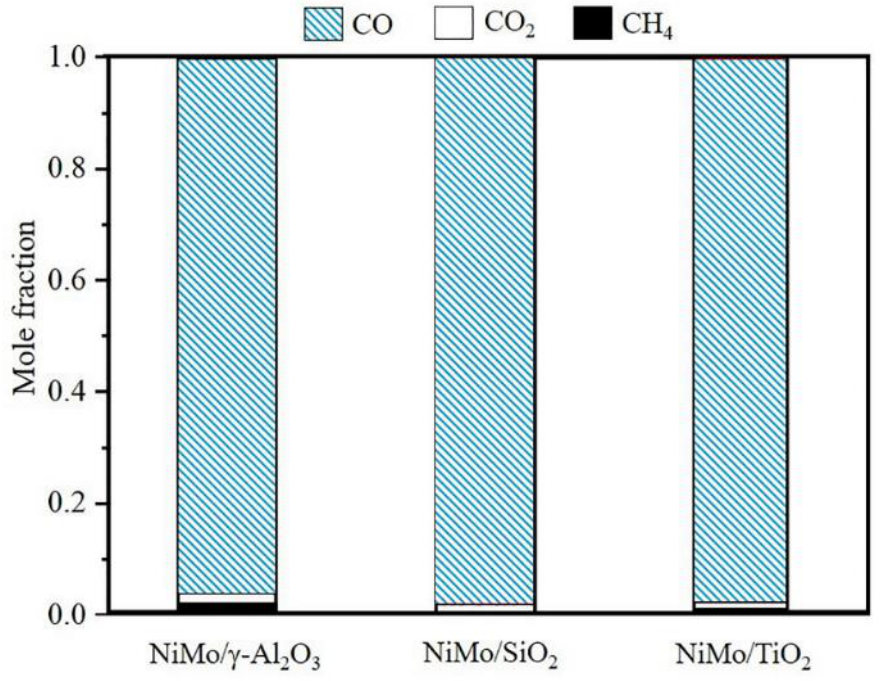
Figure 7. Mole fraction of gaseous products from the reactions (excluding hydrogen) performed over NiMo/ γ -Al 2 O 3 , NiMo/SiO 2 , and NiMo/TiO 2 catalysts. All experiments were conducted at a temperature of 330 ◦ C, H 2 pressure of 50 bar, WHSV of 1.5 h − 1 , and H 2 /oil ratio of 1000 cm 3 /cm 3